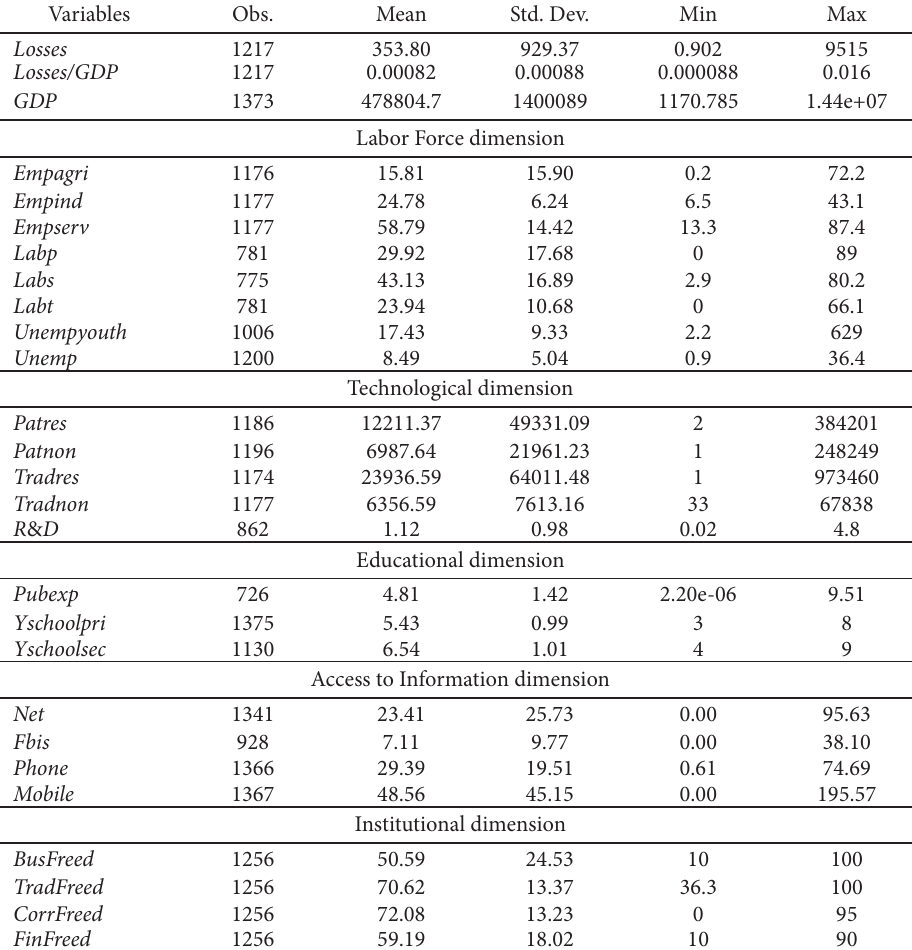
Table 1. Summary